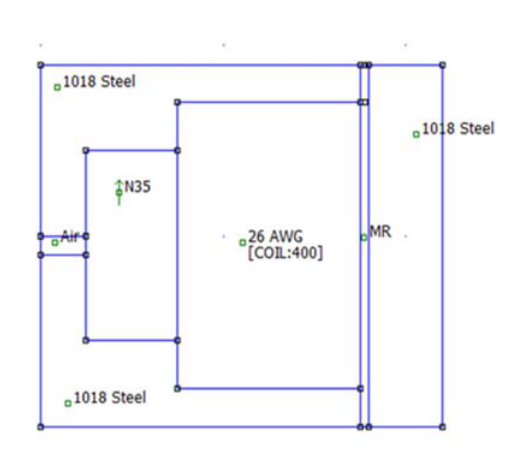
Fig. 4. The dimensions of MR valve in FEMM software